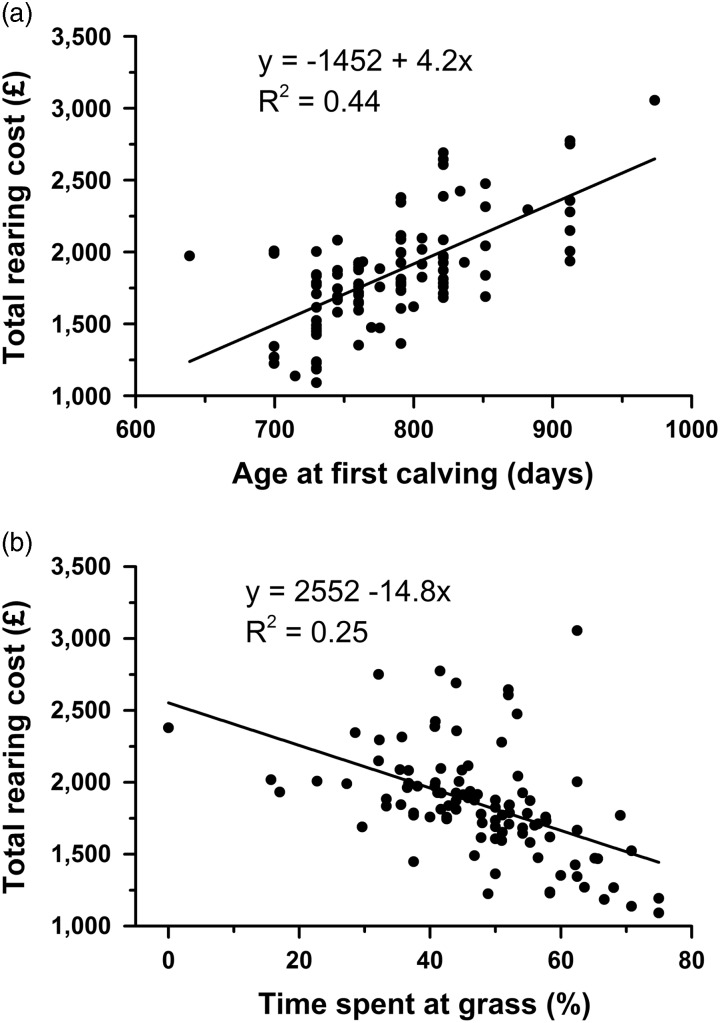
Relationship between the total cost of rearing and (a) age at first calving (days) or (b) the percentage of time that heifers spent at grass. Each symbol represents the data from one farm, n=101.